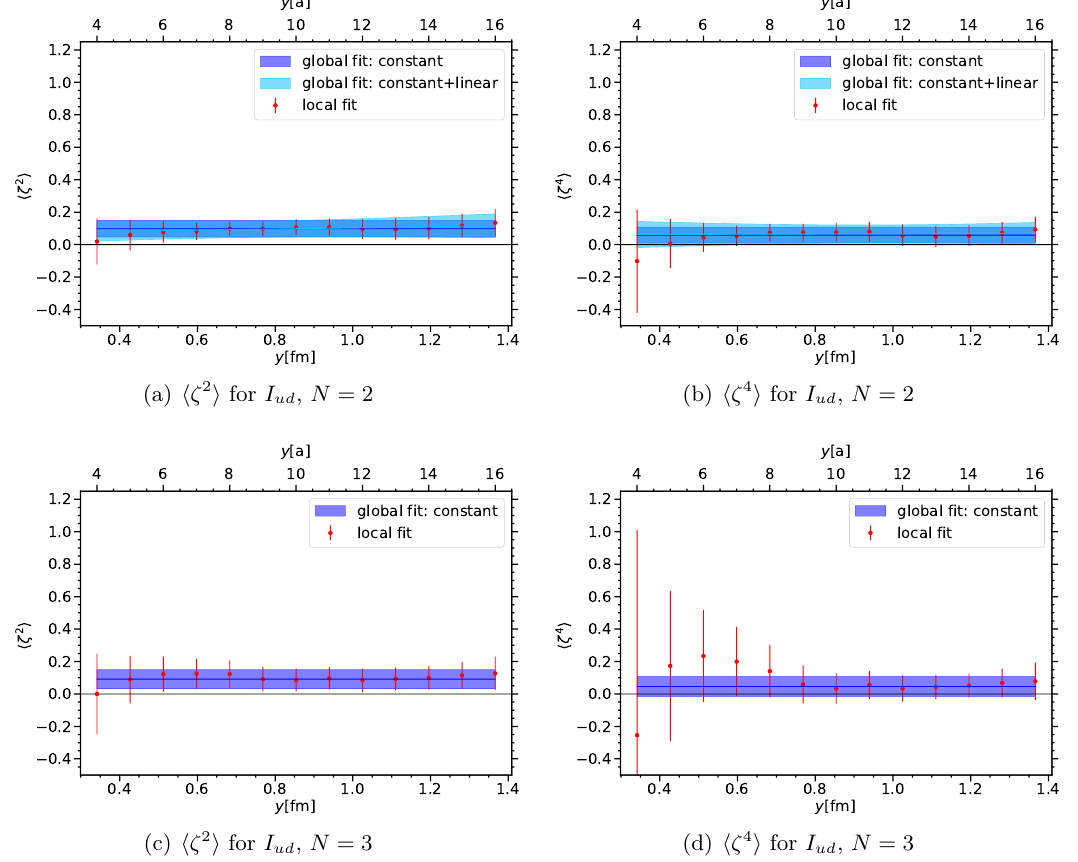
Figure 16 . Results for h ζ 2 m i obtained from the local fit (red points) compared to the global fits (bands). For N = 2 (top) we performed fits for K = 0 (dark blue), as well as K = 1 (light blue), whereas for N = 3 (bottom) we fixed K = 0 . The results are shown for the second (a,c) and the fourth moment in ζ (b,d) of the Mellin moment I ud